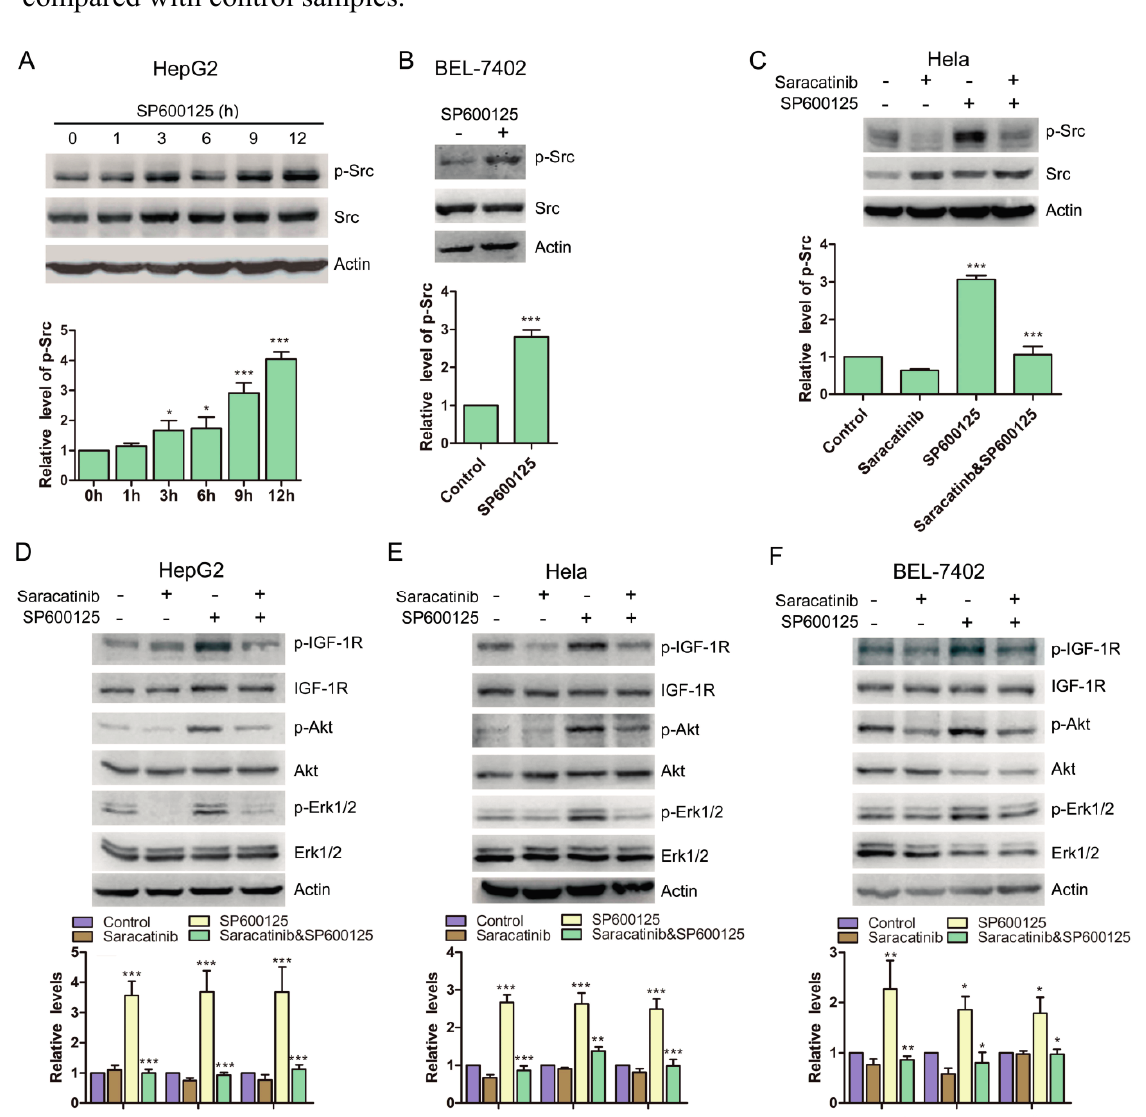
Figure 4. Src is involved in SP600125-induced IGF-1R phosphorylation. ( A ) HepG2 cells were treated with 15 µM SP600125 for the indicated time. Total protein extracts were harvested and subjected to western blot analysis of phosphorylated Src and total Src; ( B ) Bel-7402 cells were treated with 15 µM SP600125 for 48 h. Total protein extracts were harvested and subjected to western blot analysis of phosphorylated Src and total Src; ( C ) Hela cells were pretreated with 5 µM saracatinib for 3 h and then treated with or without 15 µM SP600125 for 48 h. Total protein extracts were harvested and subjected to western blot analysis of phosphorylated Src and total Src; and ( D – F ) HepG2, Hela and Bel-7402 cells were pretreated with 5 µM saracatinib for 3 h and then treated with or without 15 µM SP600125 for 48 h. Total protein extracts were harvested and subjected to western blot analysis of phosphorylated IGF-1R, Akt, Erk1/2 and total IGF-1R, Akt, Erk1/2. β -Actin was detected as loading control. The blots were subjected to densitometric analysis and relative quantification. Levels in control samples were set as 1. A representative of three experiments was shown. * , p < 0.05; ** , p < 0.01; *** , p < 0.001, compared with control